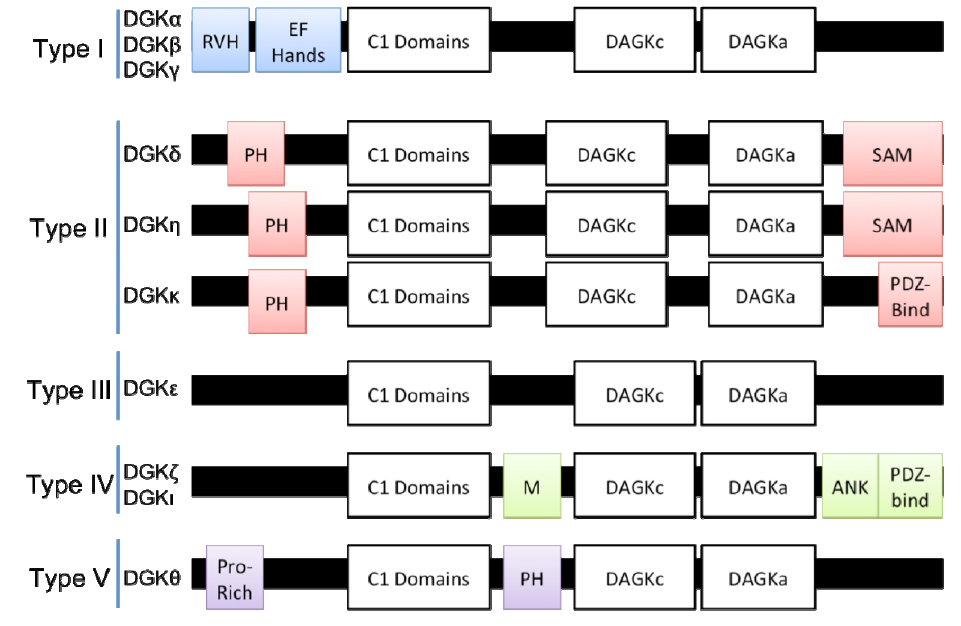
Figure 1. Diacylglycerol kinases (DGK) isoforms are divided into five subtypes based on domains apart from the C1 and catalytic domains. RVH: recoverin homology